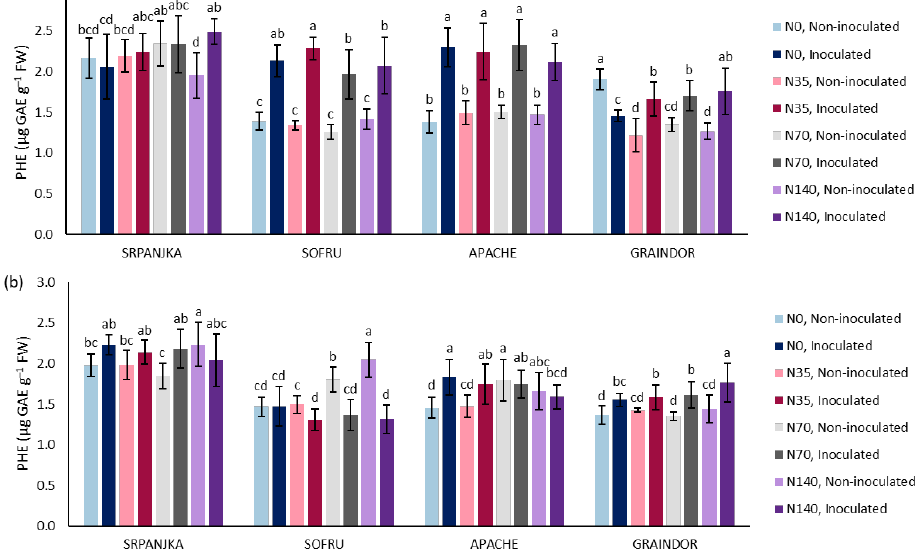
Figure 2. Soluble phenolic (PHE) content in spikes of four wheat varieties under different Fusarium (non-inoculated and inoculated) and nitrogen treatments (0, 35, 70, and 140 kg N ha − 1 ) in 2018/2019 ( a ) and 2019/2020 ( b ). Values are means of eight replicates ± standard deviation (SD). Different letters above the bars indicate significant differences according to Fisher’s LSD test ( p ≤ 0.05) among treatments in each variety separately.